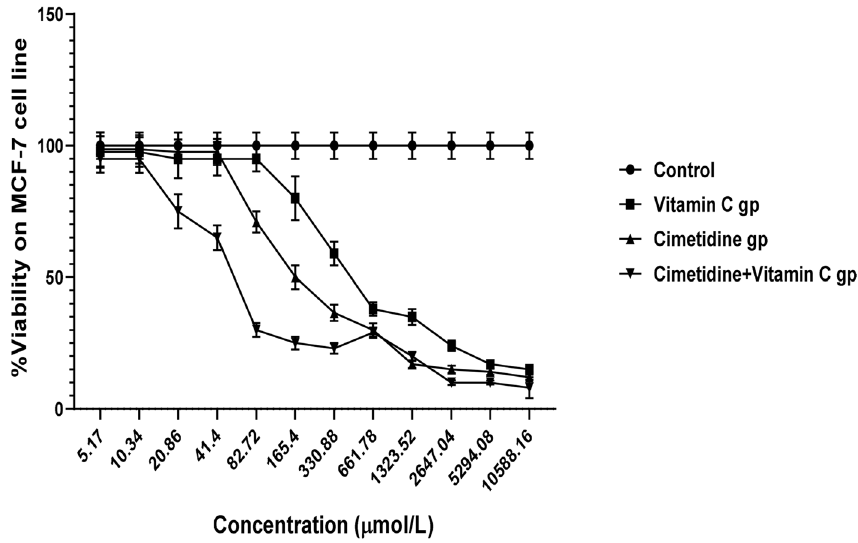
Figure 1. Effects of serial two-fold dilutions of vitamin C, cimetidine, and their combination on % of cell viability of MCF7 cells using MTT assay.